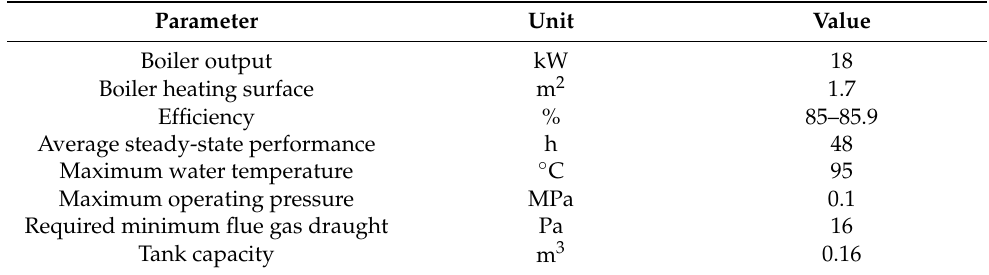
Table 1. Boiler specifications.